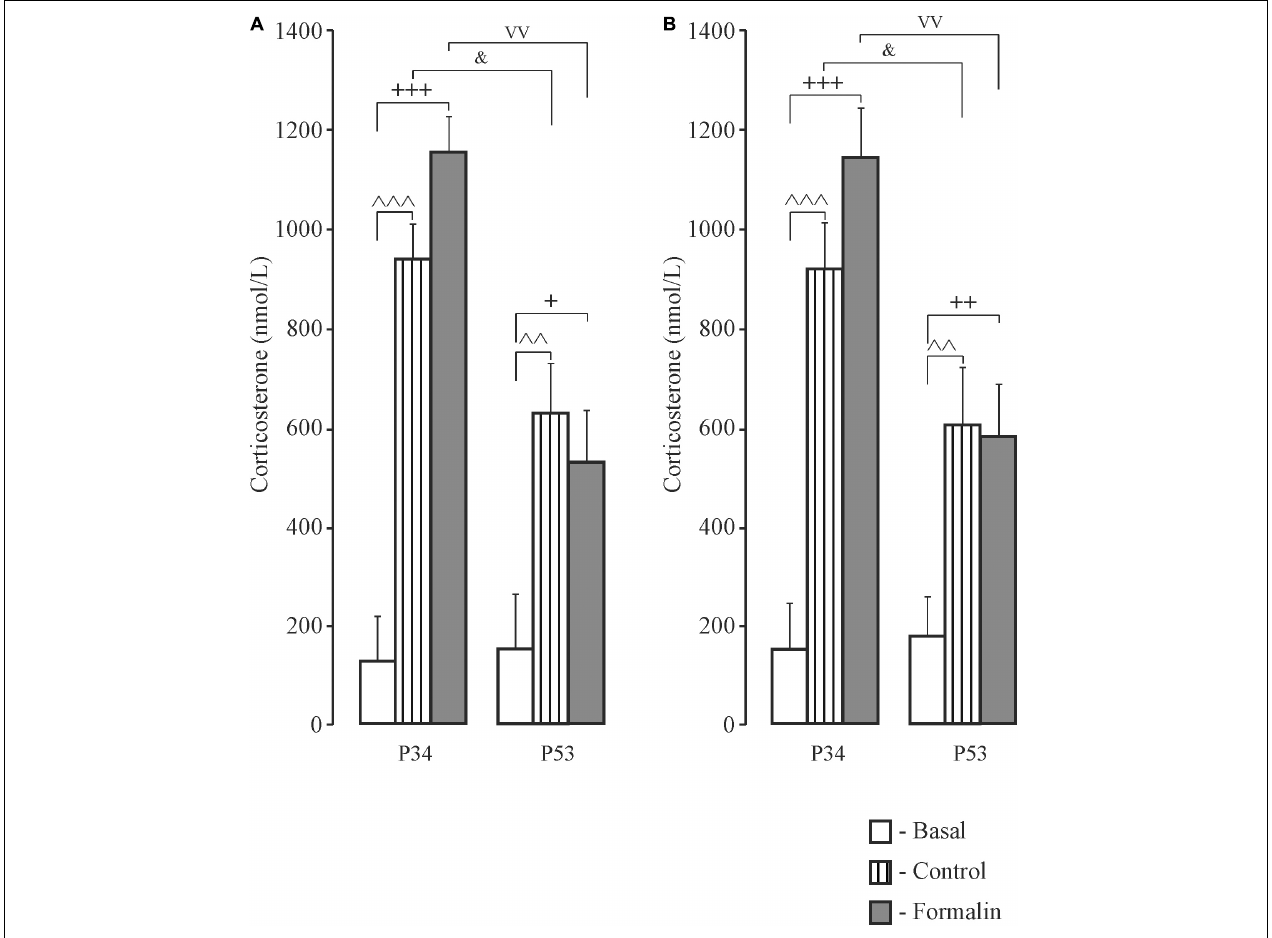
FIGURE 7 | Mean ( ± SEM) corticosterone levels in blood plasma in response to forced swimming in Control and Formalin rats at the age of P34 and P53 after testing in the Morris Water Maze. + p < 0.05, ++ p < 0.01, +++ p < 0.001, Formalin vs basal; ∧∧ p < 0.01, ∧∧∧ p < 0.001 Control vs basal; & p < 0.05, age differences between Control rats; vv p < 0.01, age differences between Formalin rats. The number of the rats in the groups corresponds to the number of rats in Figures 1 , 2